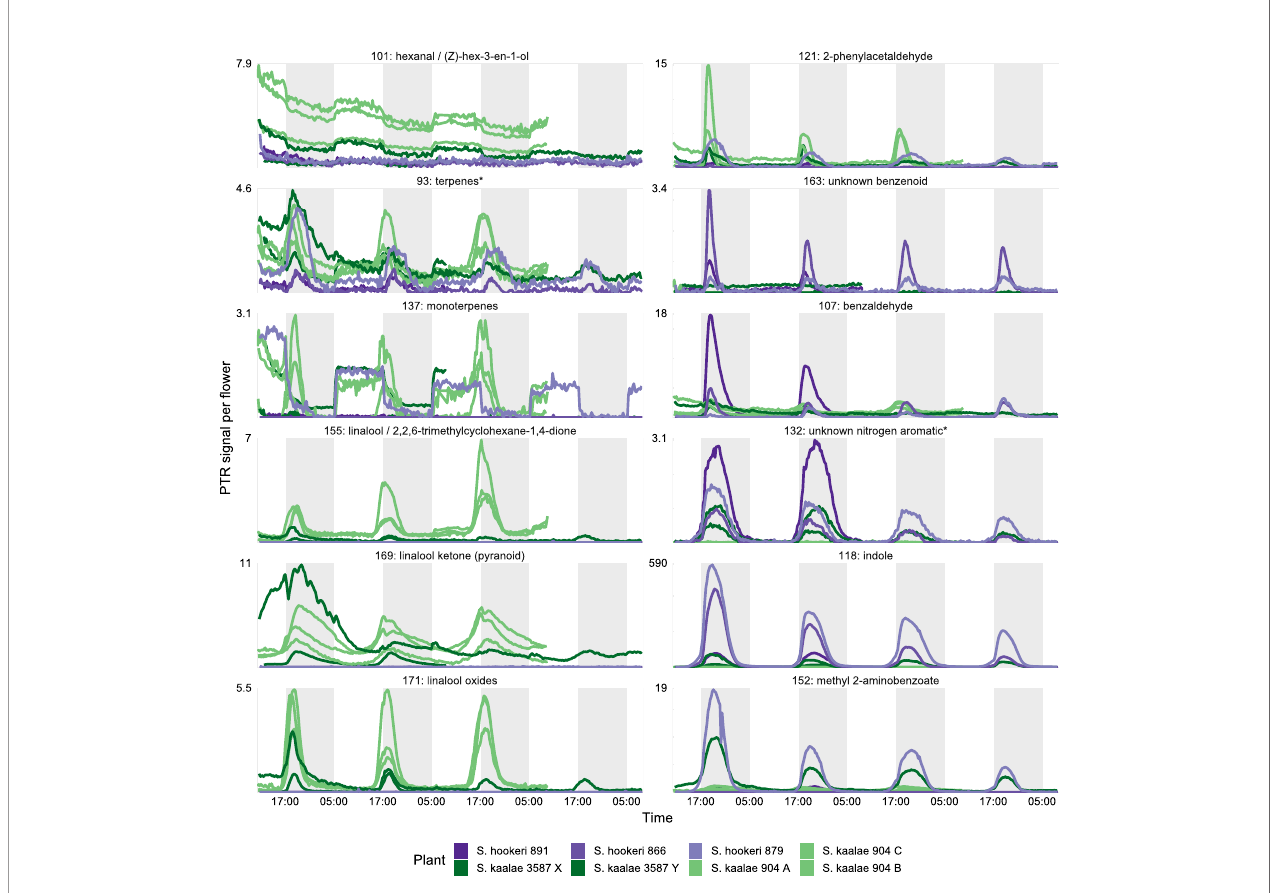
FIGURE 2 | PTR-MS signals per fl ower (arbitrary units) for fl oral volatile emissions from fi ve Schiedea kaalae plants (green shades) and three S. hookeri plants (purple shades) across 2 – 4 d. Periods of darkness in the growth chamber are indicated by darker gray shading. Plants are named with their population number and a letter (collection locations in Supplementary Table S1 ), and colored by population. Panels present those PTR-MS ion signals ( m/z value given in the label) that correspond to molecular or fragment ions of volatiles identi fi ed by GC-MS in evening scent emissions. Scales vary according to the maximum signal per fl ower, displayed next to each